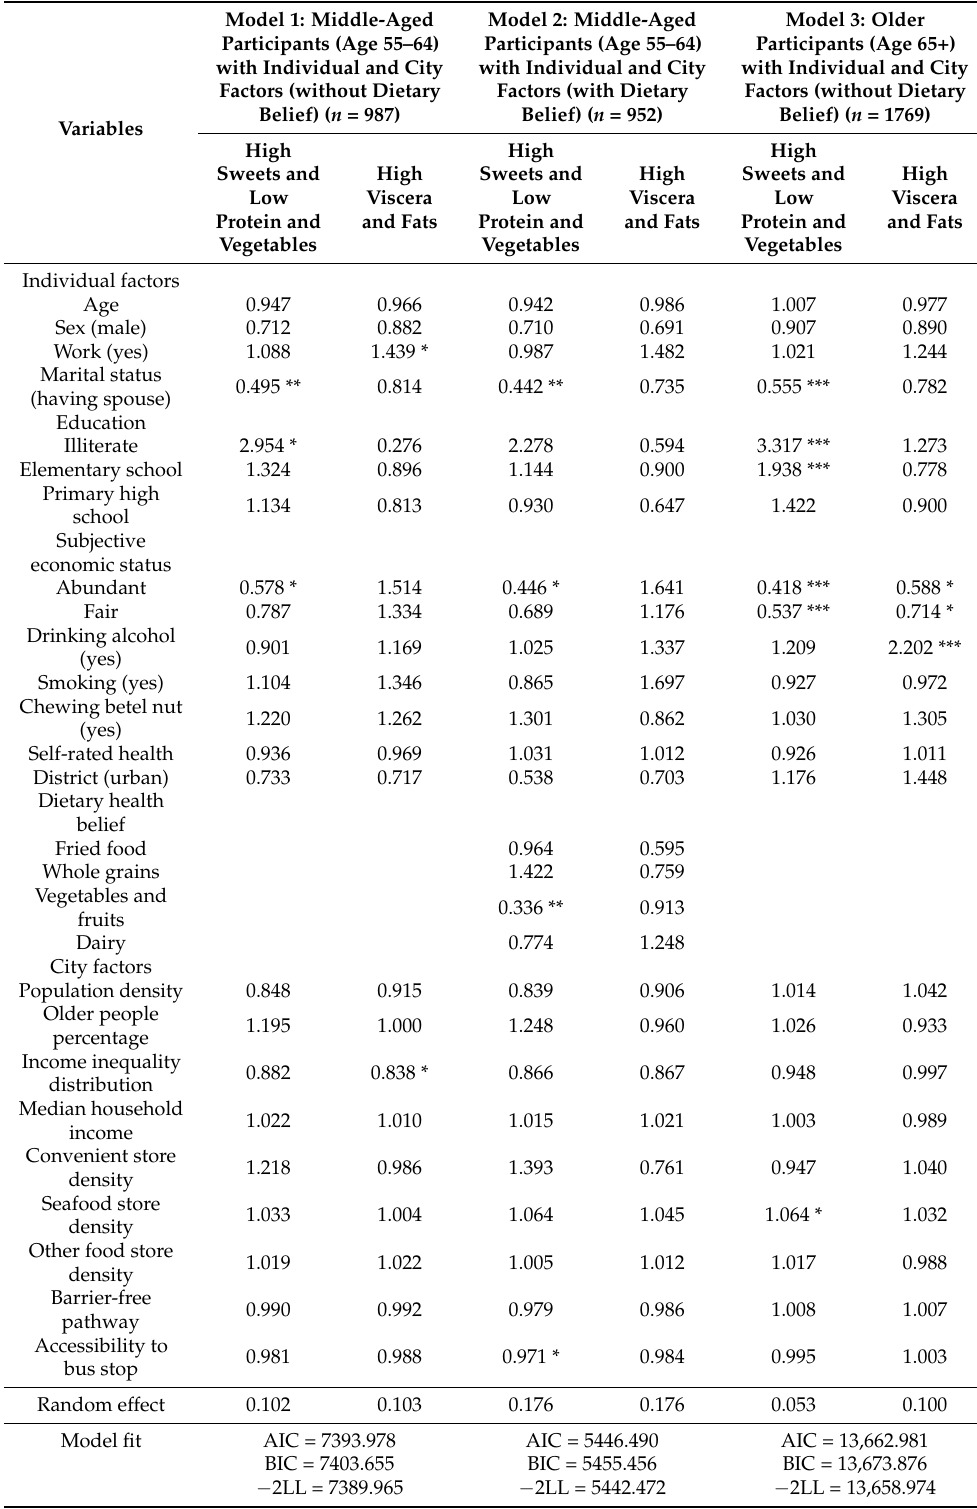
Table 3. Dietary patterns and related individual and city factors for middle-aged (age 55–64) and older people (age 65+) by multi-level multinomial logistic regression (odds